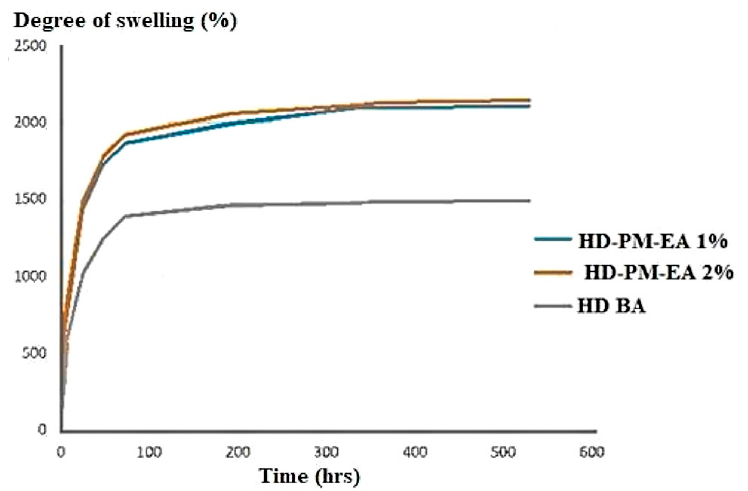
Figure 4. Degree of swelling of HD-PM-EA 2%, HD-PM-EA 1%, and basic hydrogel (HD BA).